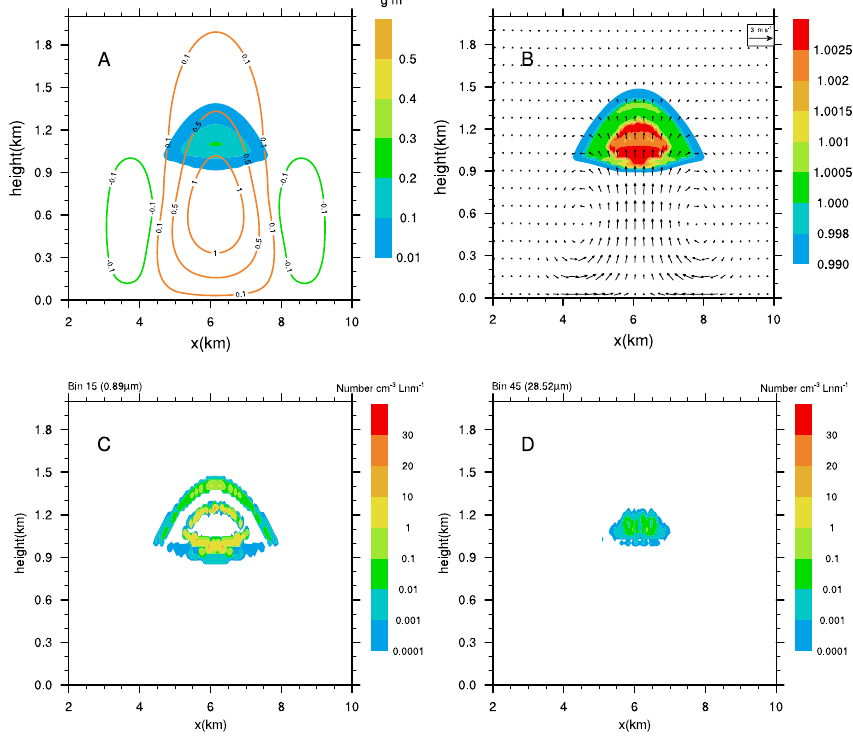
Fig. 4. The vertical cross section of the simulation at 5.5min. (A) Vertical velocity (ms − 1 ) (solid line) and liquid water content (in gm − 3 ) (shaded area), (B) Wind field and saturation ratio, (C) The number density of cloud droplets f (Lnm water , X , Z ) (Numbercm − 3 (Lnm water ) − 1 ) in 15bin (0.89µm), (D) In 45 bin